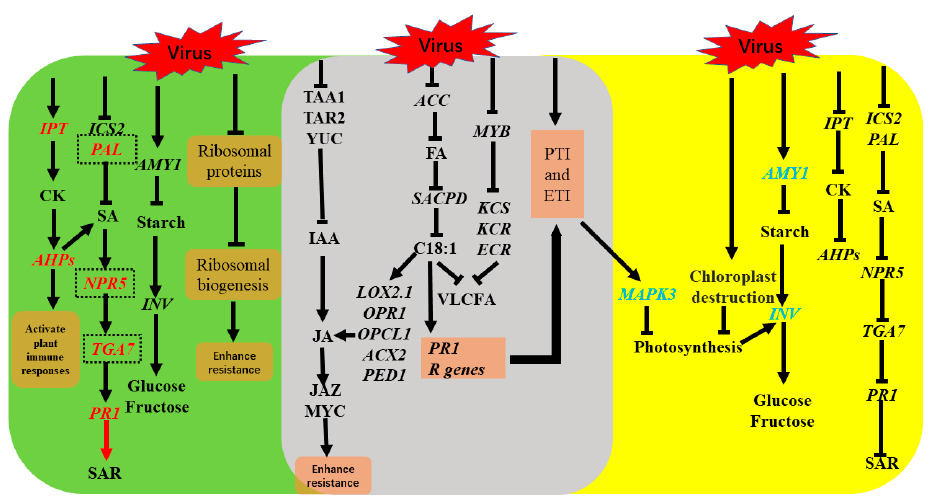
Figure 14. Proposed model for pecans: PMV interaction. Gray box shows common parts in green and yellow leaves infected with PMV. Green part shows the specific difference part in pecan infection PMV green leaves compared to pecan infection PMV yellow leaves or noninfected plants (CK) leaves. Yellow box shows the specific difference part in pecan infection PMV yellow leaves compared to pecan infection PMV green leaves or noninfected plant leaves (CK). The red text shows that the expressions of these genes in green leaves were upregulated and higher than those in yellow leaves of PMV-infected pecan plants. The blue text shows that the expressions of these genes in yellow leaves were upregulated and higher than those in green leaves of PMV-infected pecan plants. Red text with a frame shows that the expressions of these genes were suppressed, but the expression levels were higher in green leaves than those in yellow leaves of PMV-infected pecan plants. T shows that the gene transcripts were suppressed by PMV. Arrows show that the gene transcripts were induced by PMV.